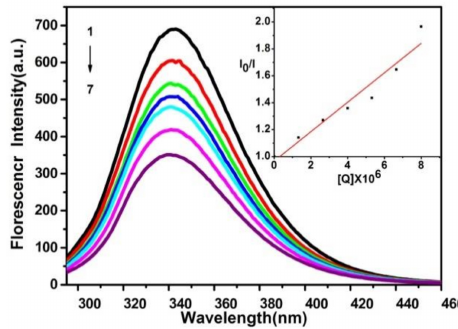
Figure 5. The effects of complex 1 on the fluorescence spectra of BSA system. [BSA] = 0.2 µ M, from 1 to 7 [complex] = 0, 1.33, 2.66, 4.00, 5.32, 6.65, 8.00 µ M, respectively; inset plot of I 0 /I versus [Q] × 10 6 . λ ex = 280